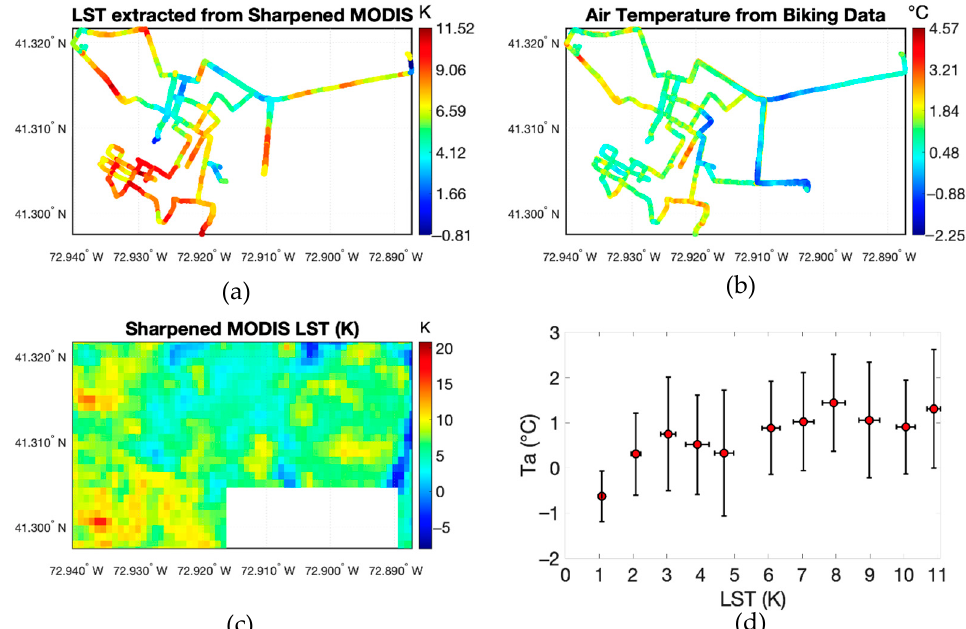
Figure 17. A comparison between air temperature (Ta) acquired with mobile sensors and LST from sharpened MODIS LST for 12 August 2019. ( a ) shows the LST values along bicycle transects, ( b ) shows Ta spatial variations, ( c ) is the sharpened MODIS LST image, and ( d ) displays the relationship between Ta and LST. The red points in ( d ) are bin averages (LST bin size 1 K) and error bars are one standard deviation.